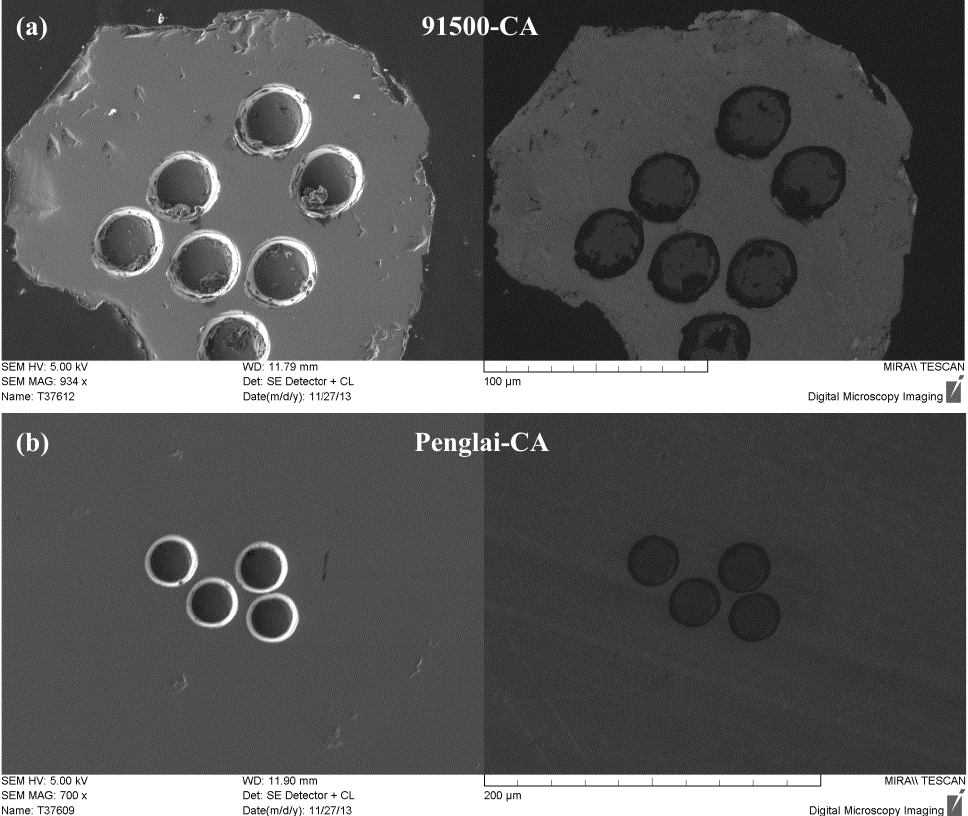
Figure 1. Secondary electron (left) and cathodoluminesence (right) images of representative zircons from: ( a ) 91500-CA; ( b ) Penglai-CA; ( c ) TSUPB021; ( d ) TSUPB021-CA; ( e ) 10/225; and ( f ) 10/225-CA. Note that “-CA” indicates zircons have been subjected to chemical